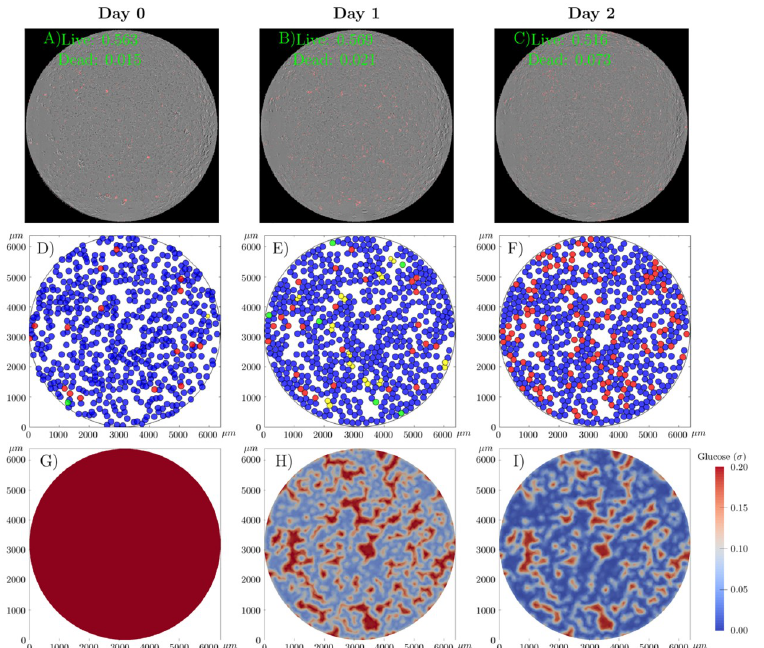
Fig 10. cgABM simulation for the scenario 2-H. Snapshots of one realization of the cgABM simulation for the scenario with high initial tumor cell confluence and 2 mM initial glucose (2-H). The whole-well images from three days of data (panels A, B, and C) show the merged images of phase contrast images and fluorescent images where dead cells were labeled in red by the Cytotox Red. The data present here is one of the four replicates of this scenario. In panels A, B, and C, the confluence of live and dead cells is presented. Spatial-temporal simulations of tumor cells (panels D, E, and F) and glucose concentration (G, H, and I) over three days. Panels A, D, and G display the initial conditions, while panels B, E, and H present the data and model at day 1, and panels C, F, and I display the data and model at day 2. The numerical simulation was performed using the MAP points of the calibrated parameters from the 2-H scenario ( � a MAP ¼ 5 : 50 � 10 (cid:0) 3 h (cid:0) 1 , � a MAP ¼ 6 : 52 � 10 (cid:0) 4 h (cid:0) 1 , λ MAP = 6.37 × 10 − 3 h − 1 , g MAP ¼ 2 : 18 � 10 (cid:0) 3 h (cid:0) 1 , P D D and s MAP ¼ 3 : 63 � 10 (cid:0) 3 ). In panels D, E, and F, the quiescent tumor cells are blue, dead cells are red, proliferative cells H are green, and the daughter cells are in yellow. As glucose is consumed by the tumor cells, its concentration drops below the threshold needed for proliferation, leading to an increase in dead cells by day 2, which is consistent with the data present in panel C. The results presented here are generated from one simulation using the MAP points. Due to the stochastic nature of the model, each run of the model produces a different result. The average error of the live and dead cells are 6.43 ± 1.01 and 3.45 ± 1.15, respectively.